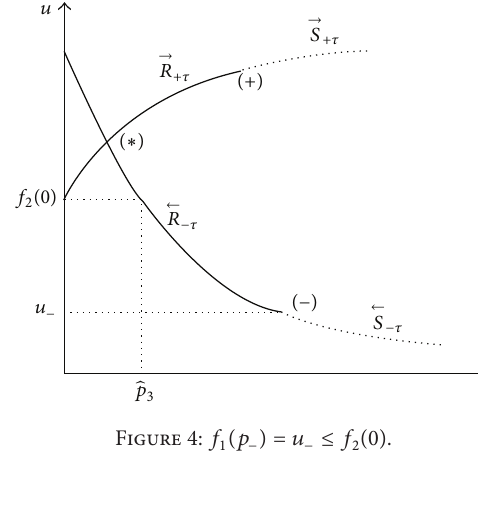
Figure 4: 𝑓 1 (𝑝 − ) = 𝑢 − ≤ 𝑓 2 (0) .